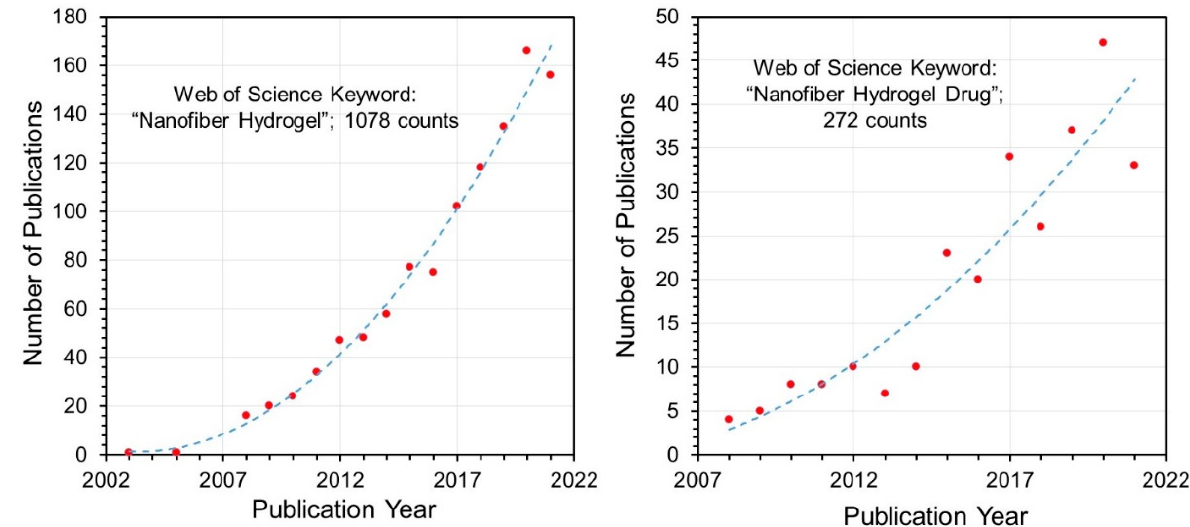
Figure 11. Web of Science keyword search results on “nanofiber hydrogel” and “nanofiber hydrogel drug” searches conducted on 18 October 2021. Number of publications as a function of publication year are plotted for both keywords. Both trends show a second-order polynomial increase.